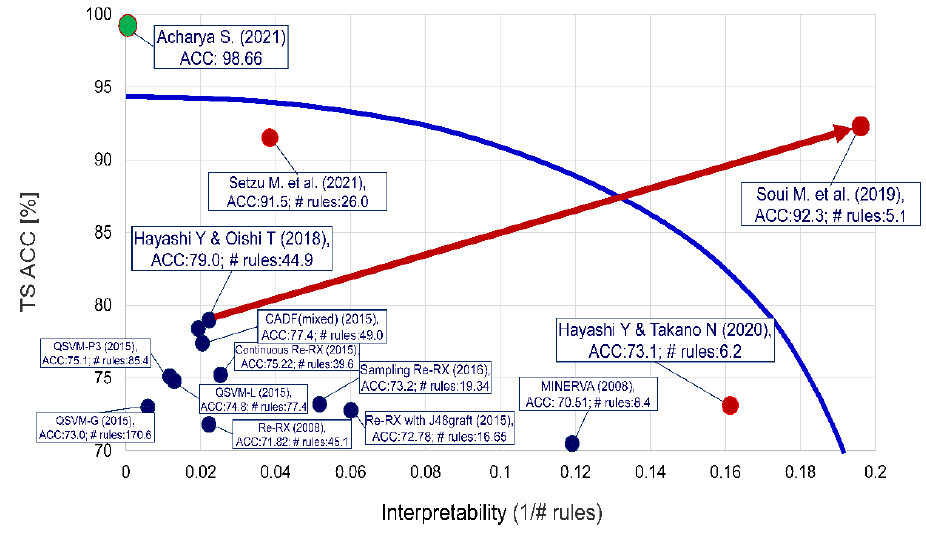
Figure 13. Tradeoff curve between accuracy and interpretability for the German (categorical) dataset [1,31,40,82,83,88]. Table 15. Performance of ensemble and hybrid classifiers, rule-based classifiers, and deep-learning- based classifiers for the German (categorical)